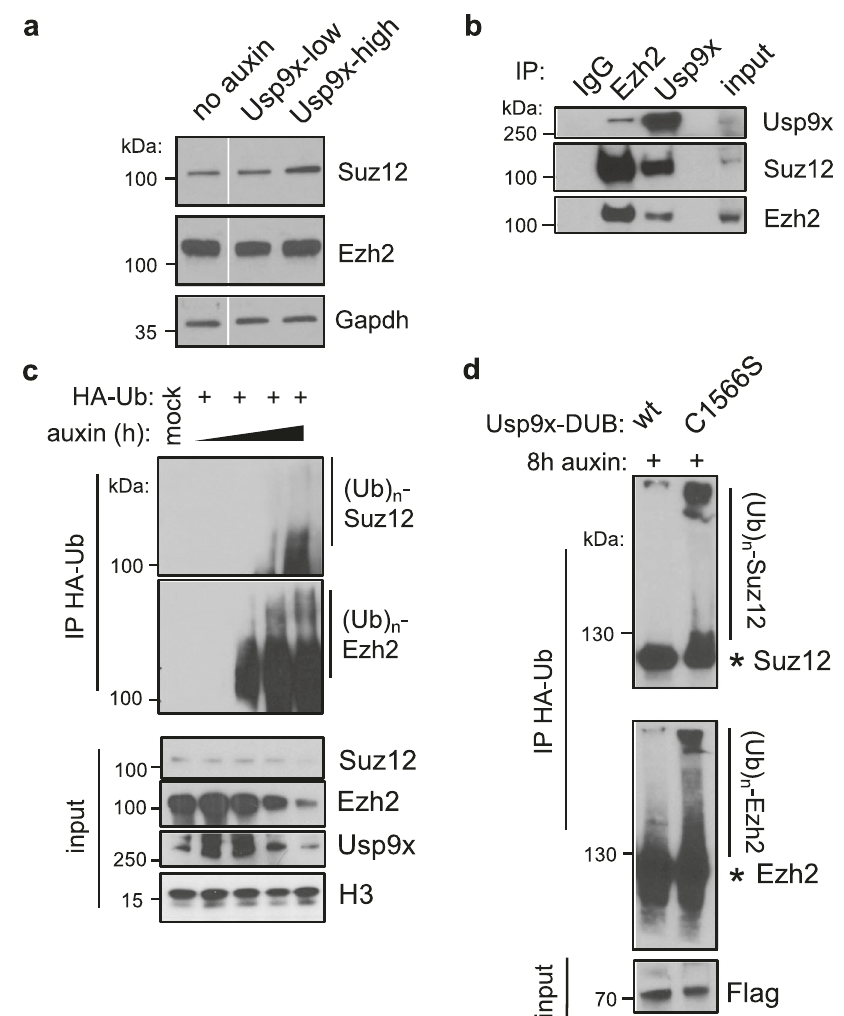
Fig. 4 Usp9x is a PRC2 deubiquitinase. a CNN western blots for Suz12 and Ezh2 proteins in whole-cell extracts. b Co-immunoprecipitation ( IP ) and western blot showing a reciprocal interaction between endogenous Ezh2 and Usp9x in wild-type ES cells. c Acute Usp9x depletion over a time course from 0 – 8 h leads to gain of ubiquitinated species of Suz12 and Ezh2 and destabilization of their protein levels. HA-Ub, HA-tagged ubiquitin; (Ub) n , polyubiquitination. d Overexpressing a catalytic mutant (C1566S) versus wild-type (wt) form of the Usp9x catalytic domain (DUB) leads to gain of Suz12 and Ezh2 ubiquitin levels. AID-Usp9x cells were treated with auxin for 8 h to deplete endogenous Usp9x. Asterisk (*) designates the expected sizes for non-ubiquitinated species. Western blots are representative of at least two biological